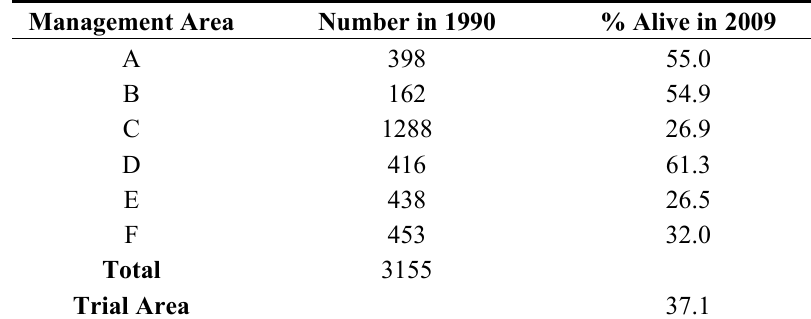
Table 4. The number of saplings in each management area during 1990 and the percentage alive in 2009 for categories 1–4.